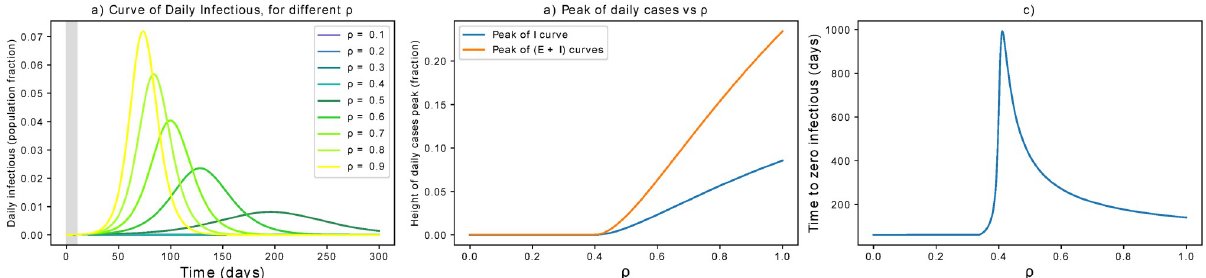
Fig 2. Effect of social distancing. (a) Effects of social distancing on the epidemic curve. The grey area indicates when measures are not yet in place. (b) The peak is progressively flattened until a mitigation is reached for sufficiently small ρ . For these settings, the critical value for ρ is 0.4 (it pushes ^ R below 1). (c) Unless ρ is small enough, stronger measures of this kind might delay the mitigation time T of the epidemic.